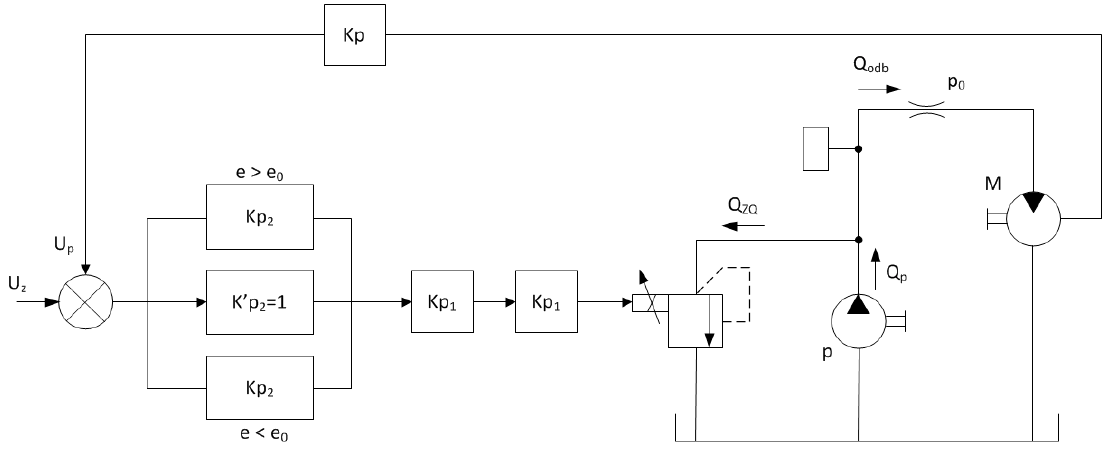
Figure 3. Diagram of the drive